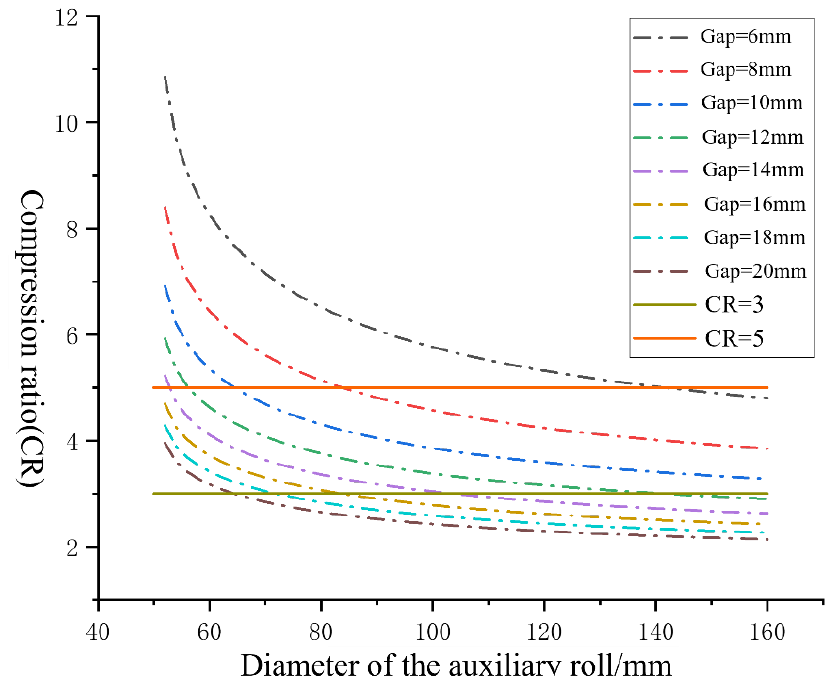
Figure 5. Compression ratios.